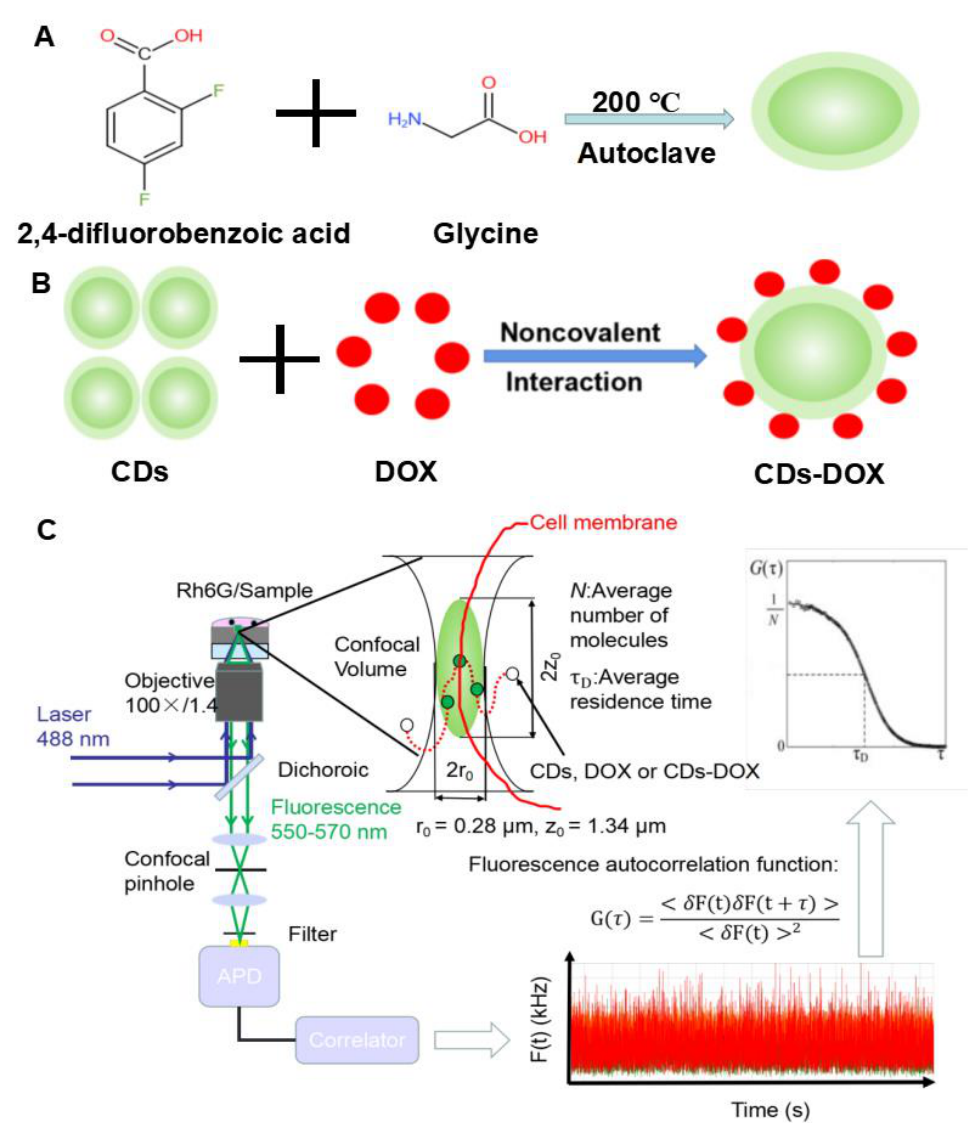
Figure 1. Schematic illustration of the preparation of CDs ( A ) and CDs-DOX ( B ) and the FCS methods to study for nanodrug transmembrane transport ( C ).